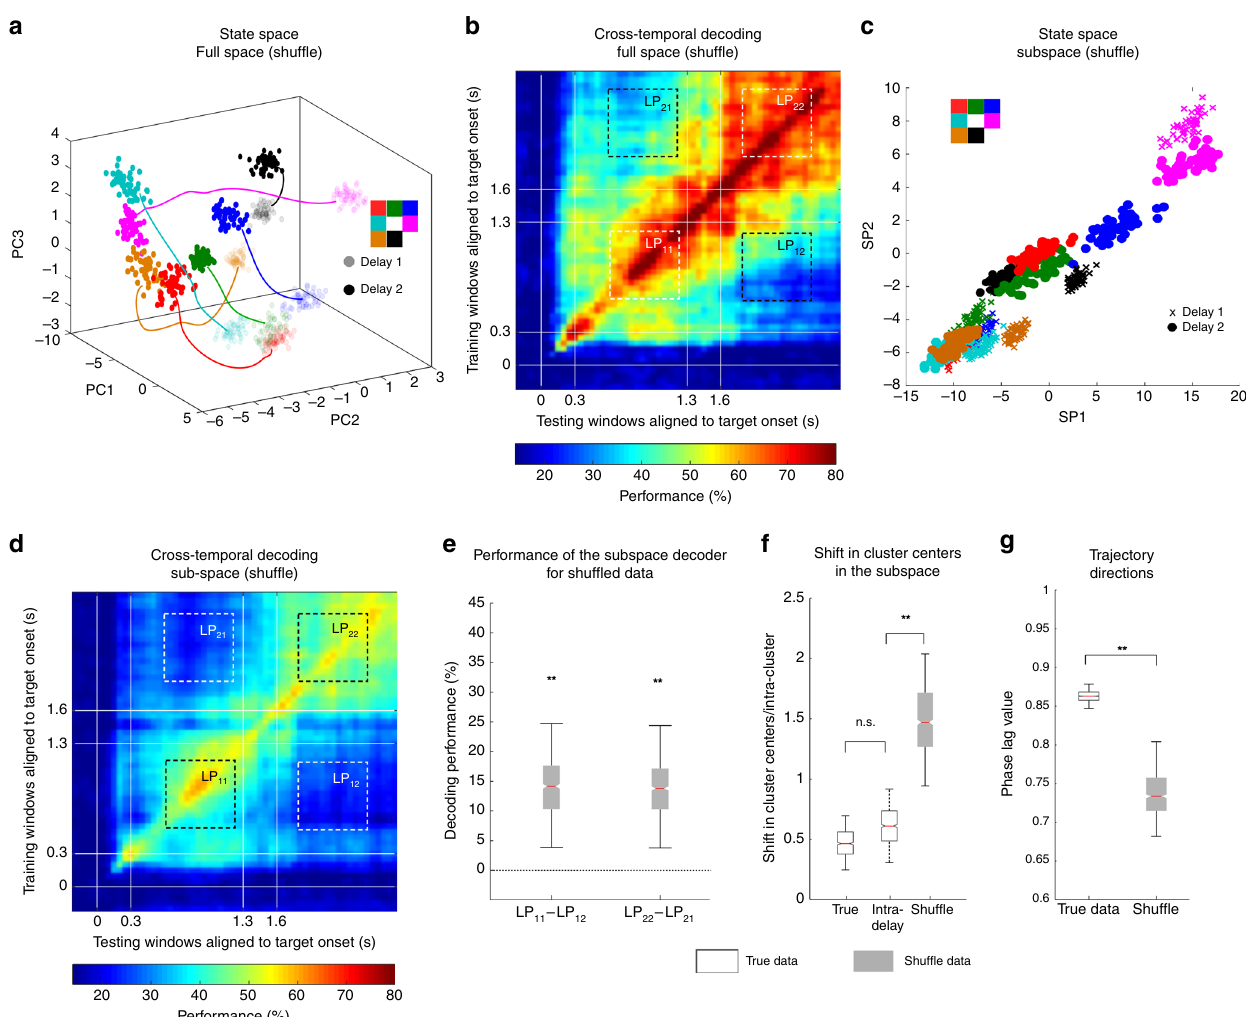
Fig. 3 Comparison of the subspace to a shuf fl ed subspace. a State space showing the target locations in Delay 2 (dark colored dots) were shuf fl ed relative to those in Delay 1 (light colored dots) before the optimization was performed in the full space. b Heat map showing the cross-temporal population- decoding performance in the full space with the target location in Delay 2 shuf fl ed relative to those in Delay 1. c Delay 1 (plotted using crosses) and shuf fl ed Delay 2 (plotted using open circles) responses after projection into the top 2 dimensions of the subspace. Points for different target locations are color- coded according to the color scheme shown in the top left. d Heat map showing the cross-temporal population-decoding performance in the subspace with the target locations in Delay 2 shuf fl ed relative to those in Delay 1. e The difference in decoding performance when a decoder that was trained on the Delay 1 responses shown in c was tested on Delay 1 (LP 11 ) or Delay 2 (LP 12 ) responses are shown in the gray box-plot labelled LP 11 - LP 12 , and vice versa (labelled LP 22 - LP 21 ). f The shift in cluster centers from Delay 1 to Delay 2 in the subspace, normalized to the average intra-delay distance, is shown for the true data (black box-plot) and the shuf fl ed data (gray box-plot). The boxplot in the middle illustrates the intra-delay shifts for comparison. g The magnitude of the vector obtained by averaging the trajectory vectors from Delay 1 to Delay 2 for each target location is shown for the true data (black box-plot) and the shuf fl ed data (gray box-plot). The bounds in the boxplots are de fi ned by the 25th and 75th percentile of the distribution. The red line represents the median and the whiskers represent the 2.5th and 97.5th percentile of the